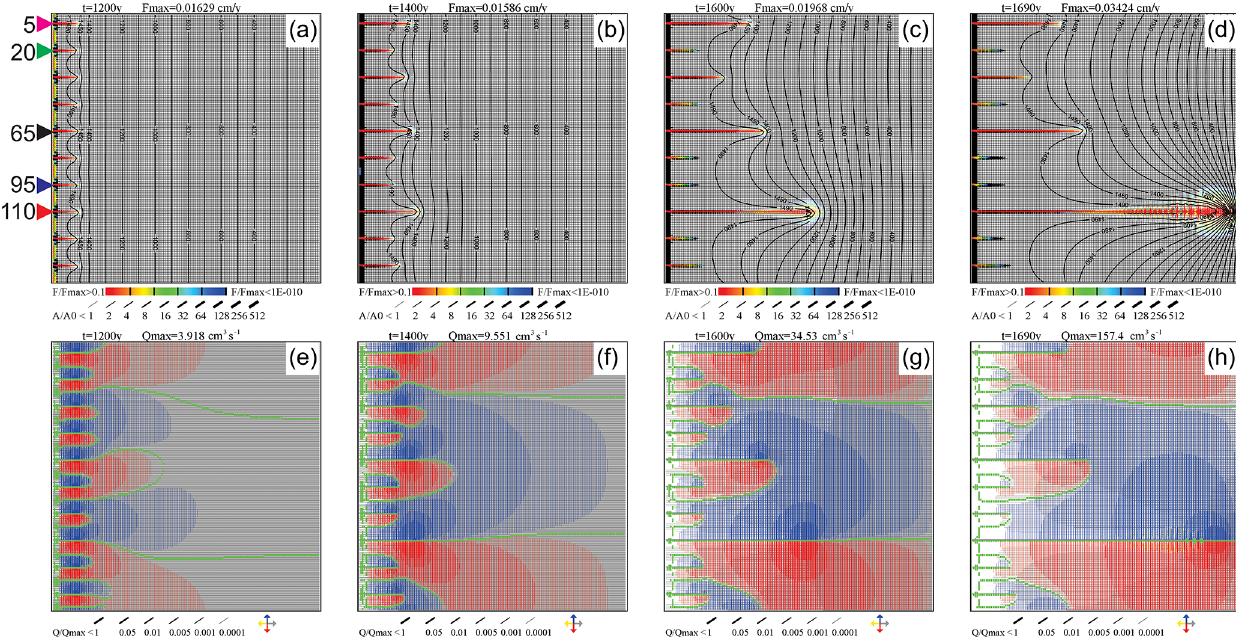
Figure 15. Interaction of set of wormholes seeded at the distance of 15 nodes. Triangles and numbers denote location and y coordinates of inputs into the selected